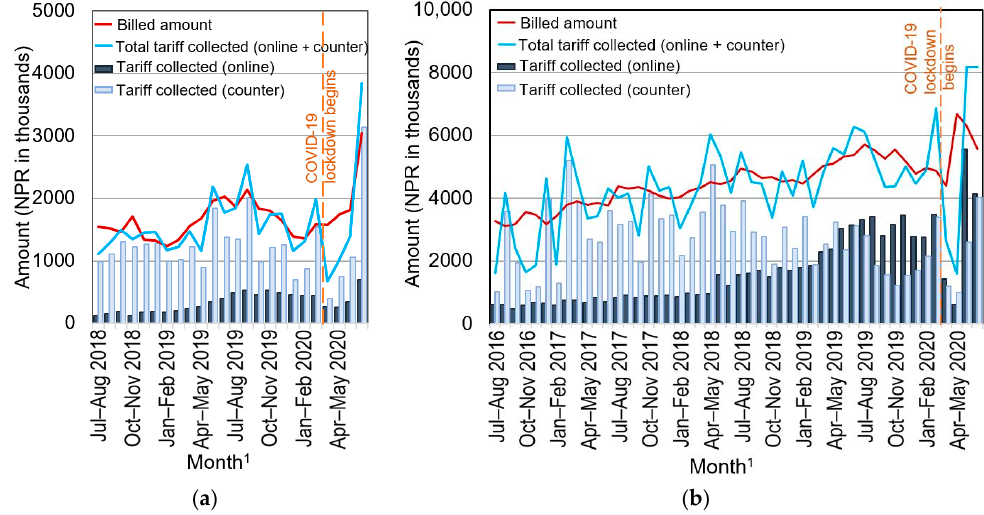
Figure 3. Payment activities 2 : ( a ) Birat and ( b ) Lekhnath. 1 Jul–Aug 2018: July to August 2018 corresponds to Shrawan, 2075 in Nepalese calendar (FY starts in Shrawan ). 2 1 USD ≈ 115 NPR.